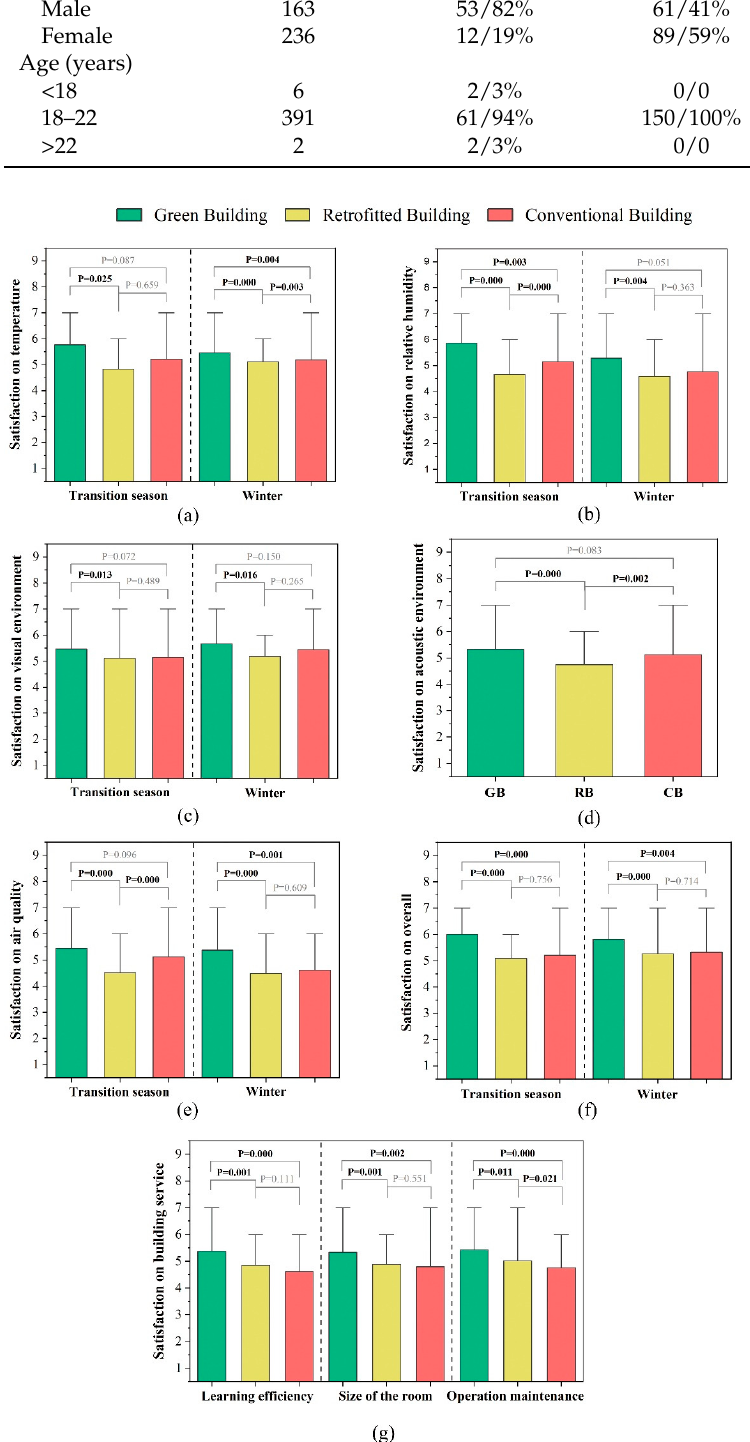
Figure 6. Comparison of occupant satisfaction with ( a ) temperature, ( b ) relative humidity, ( c ) visual environment, ( d ) acoustic environment, ( e ) air quality, ( f ) overall environment, and ( g ) building services in GB, RB, and CB.